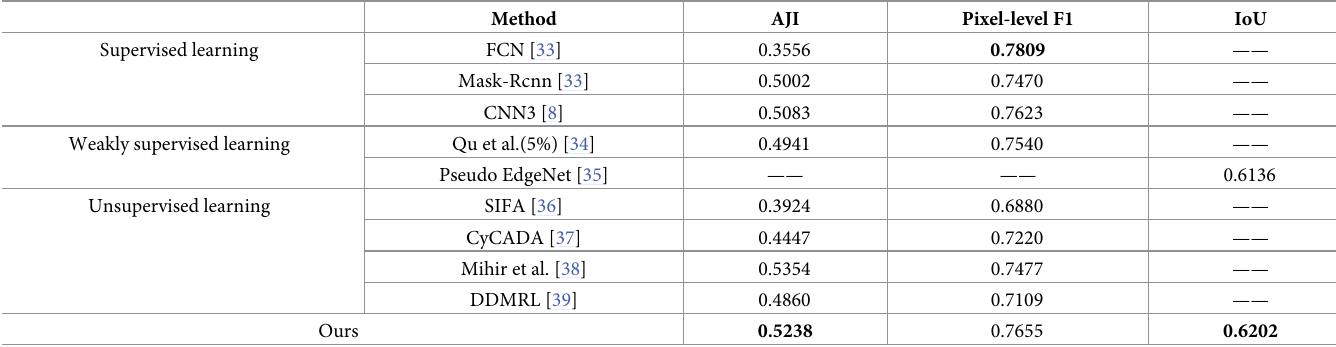
Table 6. Comparison experimental results on Kumar dataset.